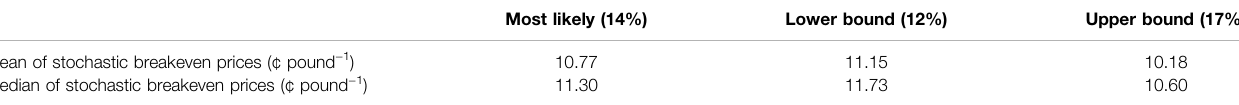
TABLE 3 | Stochastic oilseed breakeven prices or MBPs a prospective crushing facility could pay farmers for pennycress feedstock across estimated discount rates.